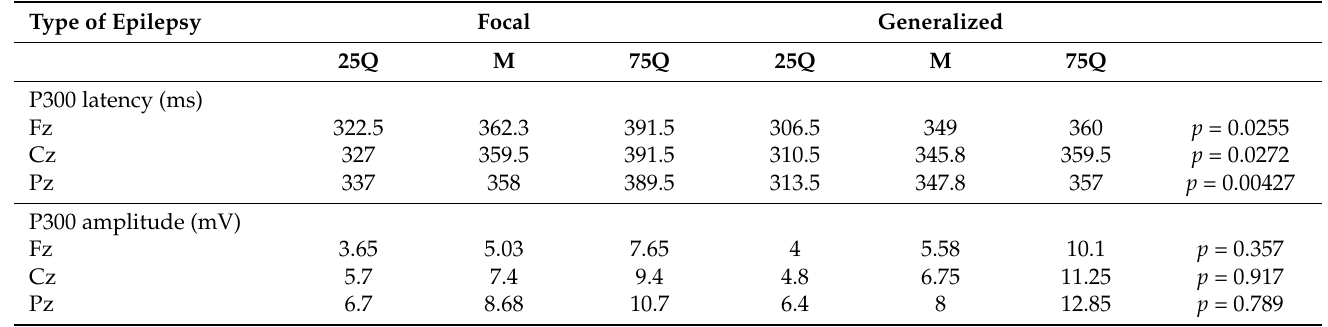
Table 6. Analysis of correlation between P300 parameters in the study group and the type of epilepsy